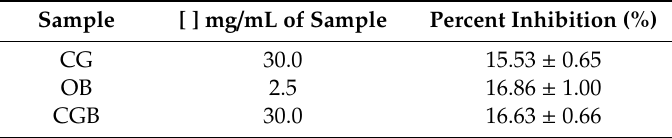
Table 5. Inhibition of hyaluronidase activity by gels samples of pure chitosan (CG) and associated with buriti oil (CGB) and buriti oil (OB).